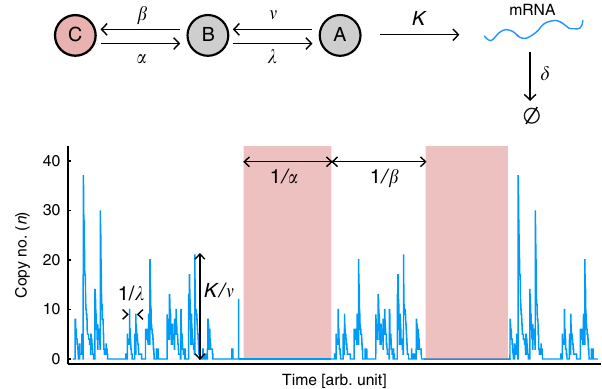
Fig. 2 Model of transcription used in this study. We consider a multi-state stochastic model in which the promotor transitions between a deep inactive state (C), a primed inactive state (B) and an active state (A) in which transcription can occur. Slow switching between states C and B leads to an abundance of cells with no expression level. Rapid switches between states B and A lead to bursty transcription, in which bursts of average size K / v occur at an average frequency λ / δ